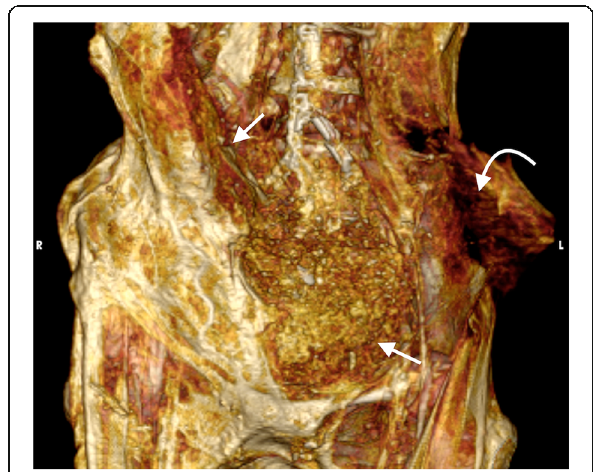
Fig. 6 Three-dimensional reconstructed CT image in frontal projection of the abdomen and pelvis of “ Unknown-Woman-A ” shows left inguinal incision. The gaping left inguinal evisceration incision (curved arrow) is well shown. The disrupted anterior abdominal wall (likely inflicted by tomb robbers) reveals embalming material packs (straight arrows) within the body